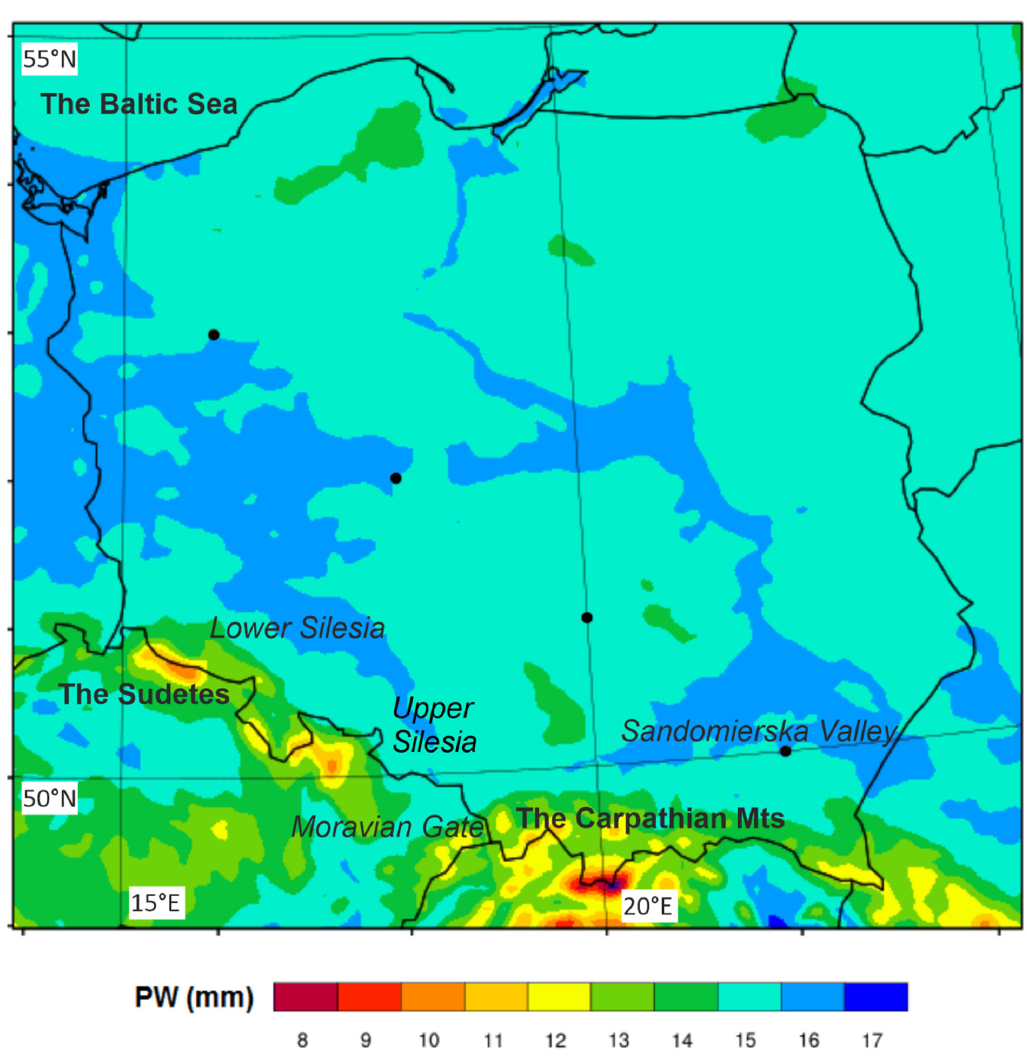
Figure 5. Annual PW value over Poland for the years 1983–2010. The black points indicate the places used in trend analysis. used in trend